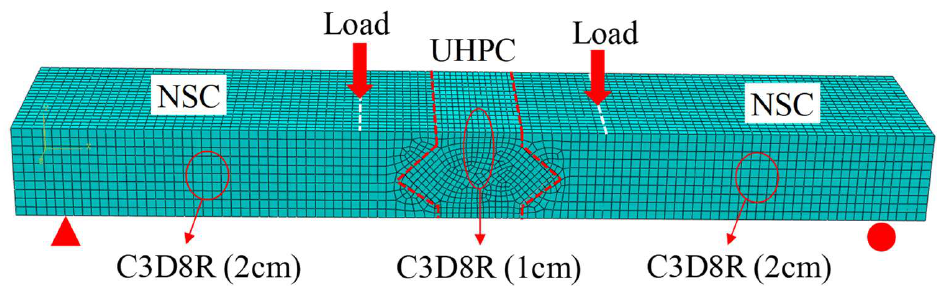
Figure 8. An example of finite element models (J-D).